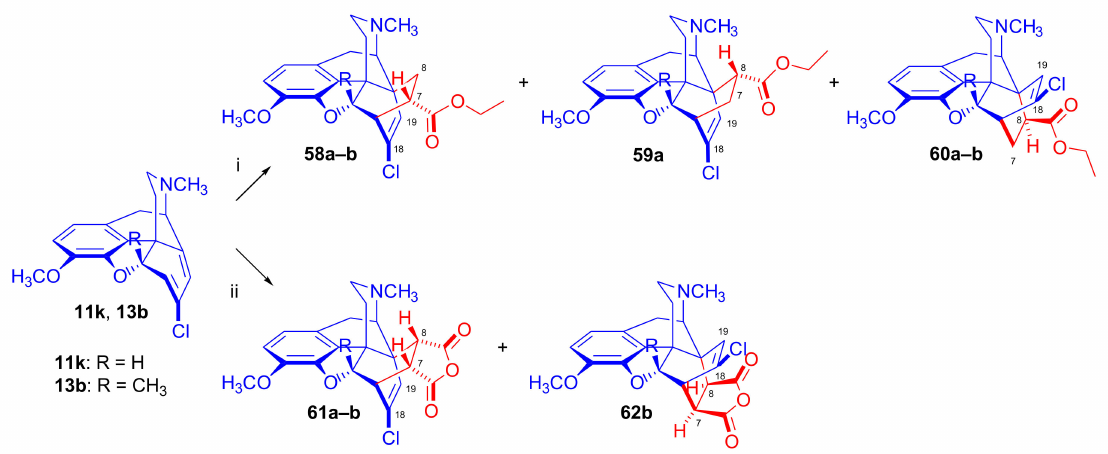
Figure 19. Cycloaddition reactions of 7-chloro-6-demethoxythebaine and 7-chloro-5 β -methyl-6- demethoxythebaine. Reagents and conditions : (i): ethyl acrylate, reflux, four days ( 11k )/two weeks ( 13b ), (ii): maleic anhydrid, toluene, reflux, one day ( 11k )/two weeks ( 13b ).